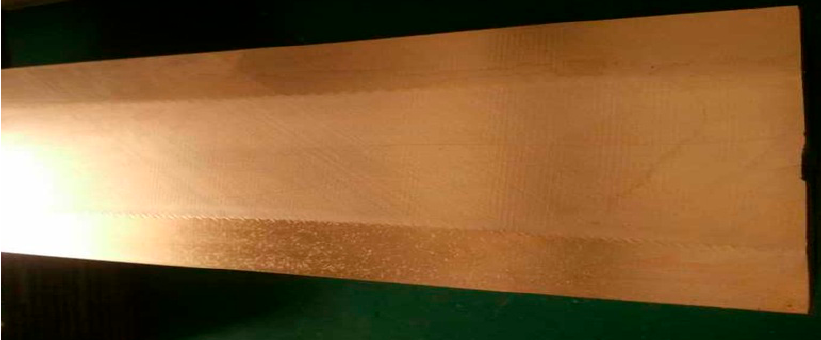
Figure 9. Narrow-face copper wall after FTSC corner thinning design.